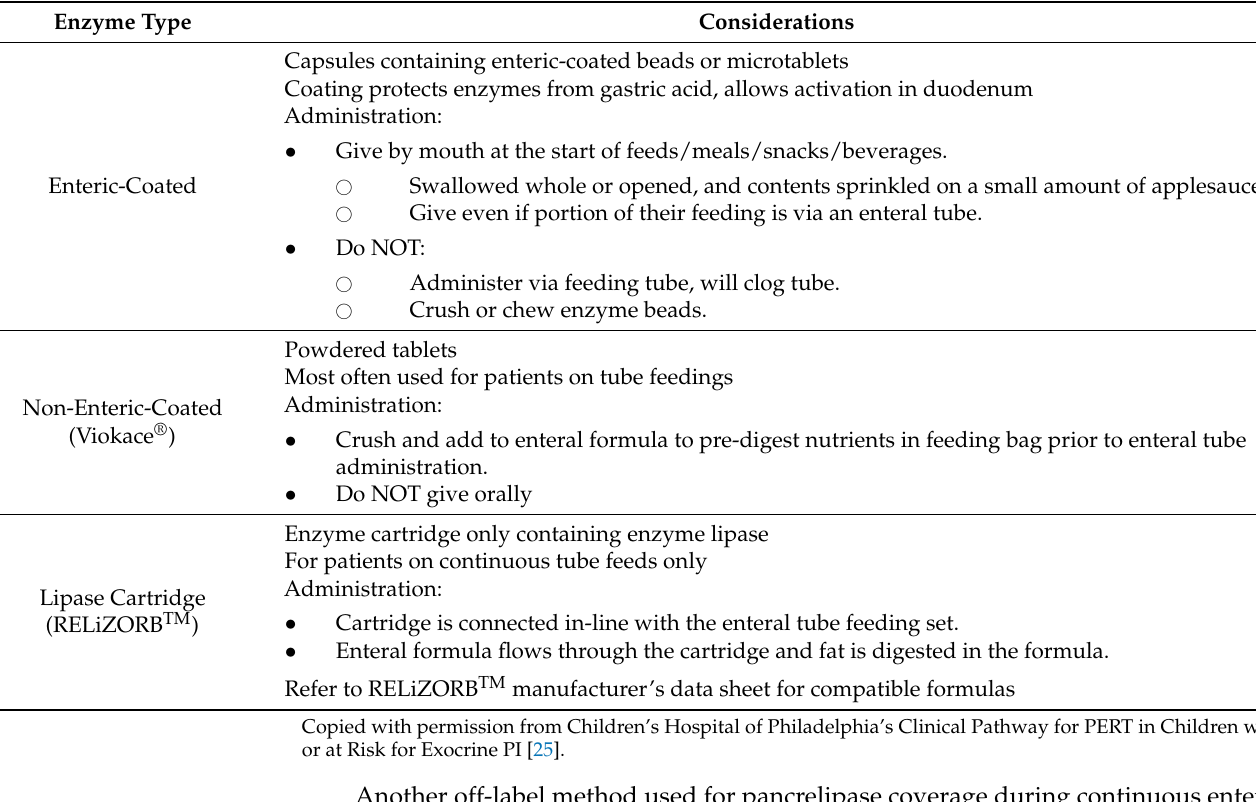
Table 3. Enzyme Types and